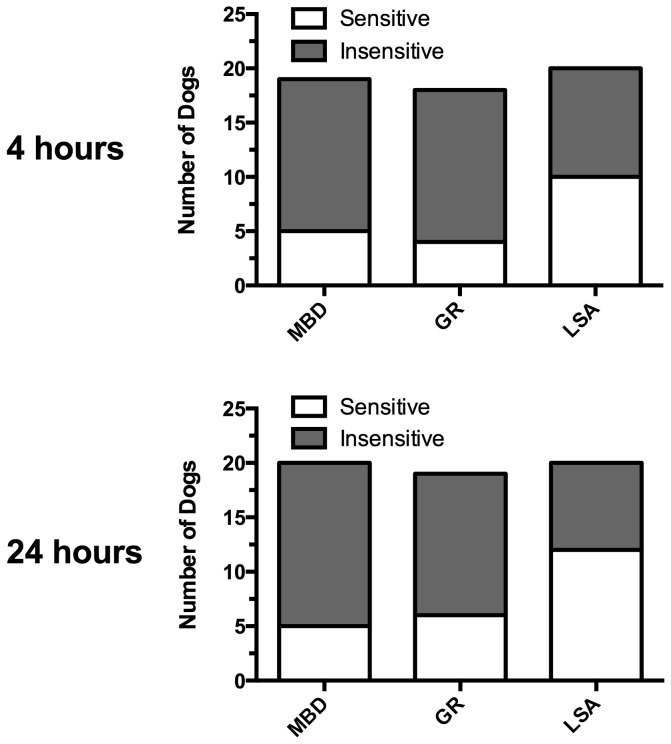
Proportions of dogs “sensitive” and “insensitive” to induction of chromosomal damage following bleomycin exposure.Dogs were defined as “sensitive” if the number of gross chromatid breaks exceeded the 75th percentile of the reference (normal mixed-breed dog) population. The proportion of dogs demonstrating sensitivity to induction of damage following bleomycin exposure was higher in golden retrievers with lymphoma (LSA) than in clinically normal golden retrievers (GR) or normal mixed-breed dogs (MBD), which even though it did not reach statistical significance (p = 0.10 and 0.11 for 4 and 24 hours respectively, LSA vs GR), does support DNA repair deficiency in the golden retrievers with lymphoma.